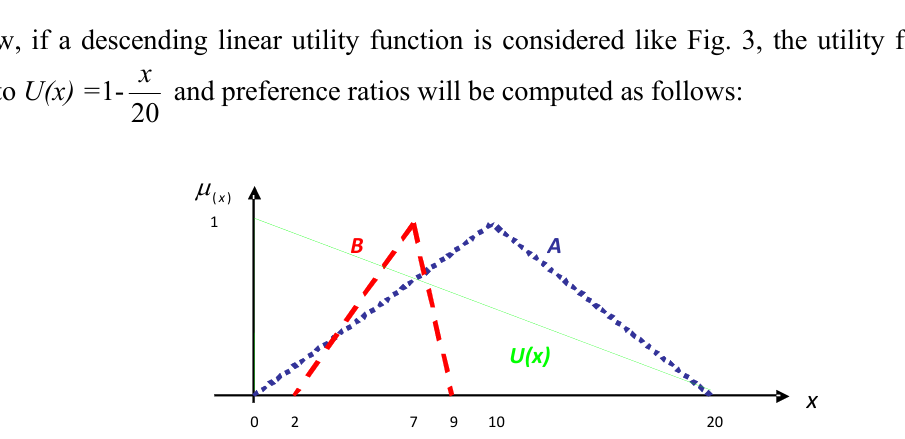
Fig. 3. Comparison of fuzzy numbers A=(0,10,20) and B=(2,7,9) considering a descending linear utility